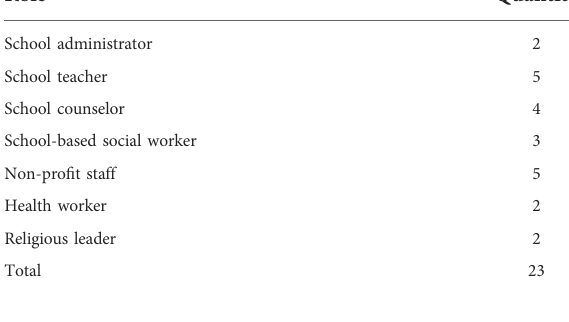
TABLE 2 Key information interview professional roles.